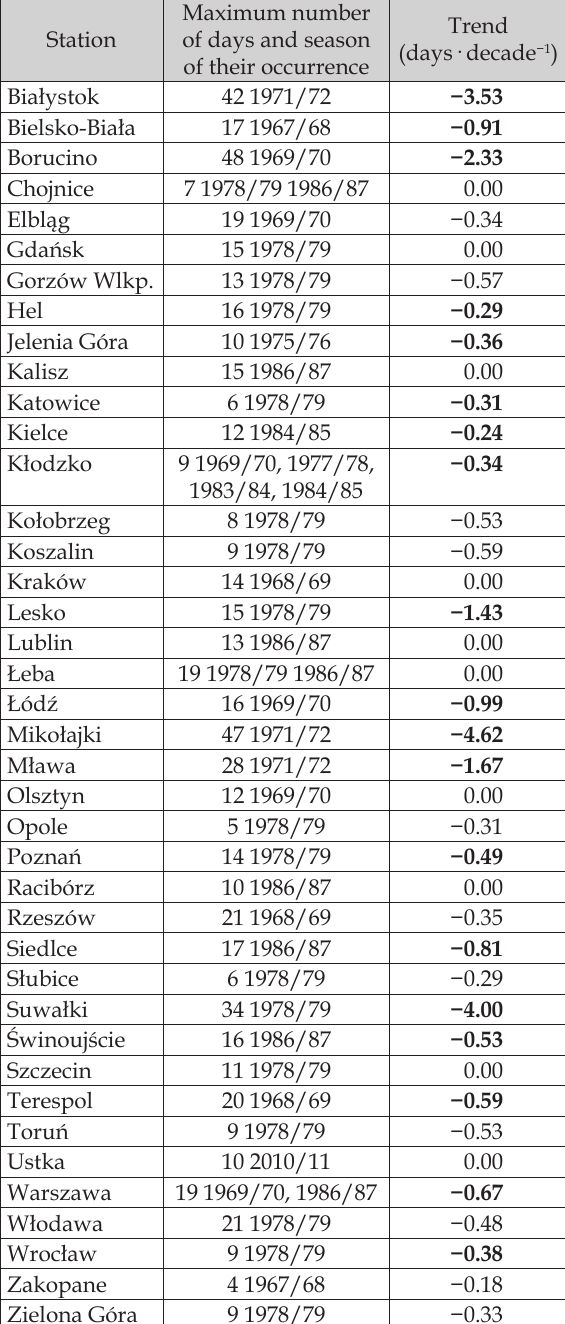
Table 1. Selected characteristics of the number of days with very strong and extreme cold stress according to UTCI in Poland, 1966/67 to 2018/19: their maximum number and trend coefficient. Statistically significant (at 0.05 level) trend values are in bold.